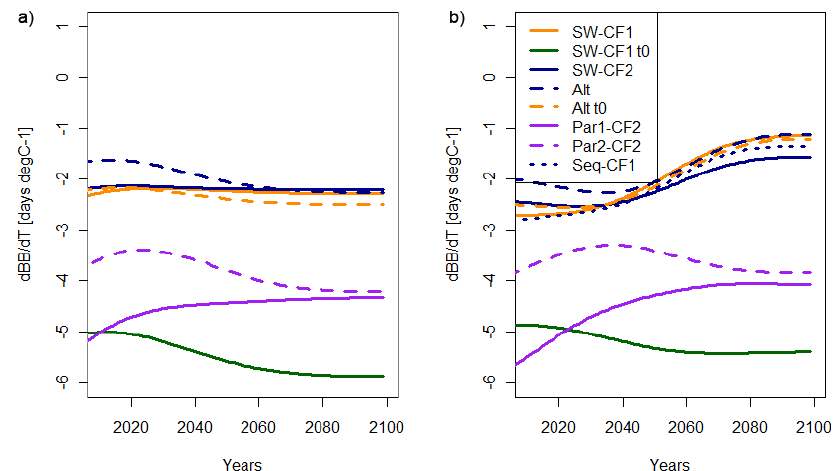
Fig. 7. Future sensitivity of bud-burst to temperature (dBB/d T ) as projected by different phenological models under the scenario A1fi (a) and the scenario B1 (b) . (dBB/d T ) is computed as the ratio between the smoothed bud-burst projections for each model and the smoothed temperature. Different lines represent some of the most representative models listed in Table 2.